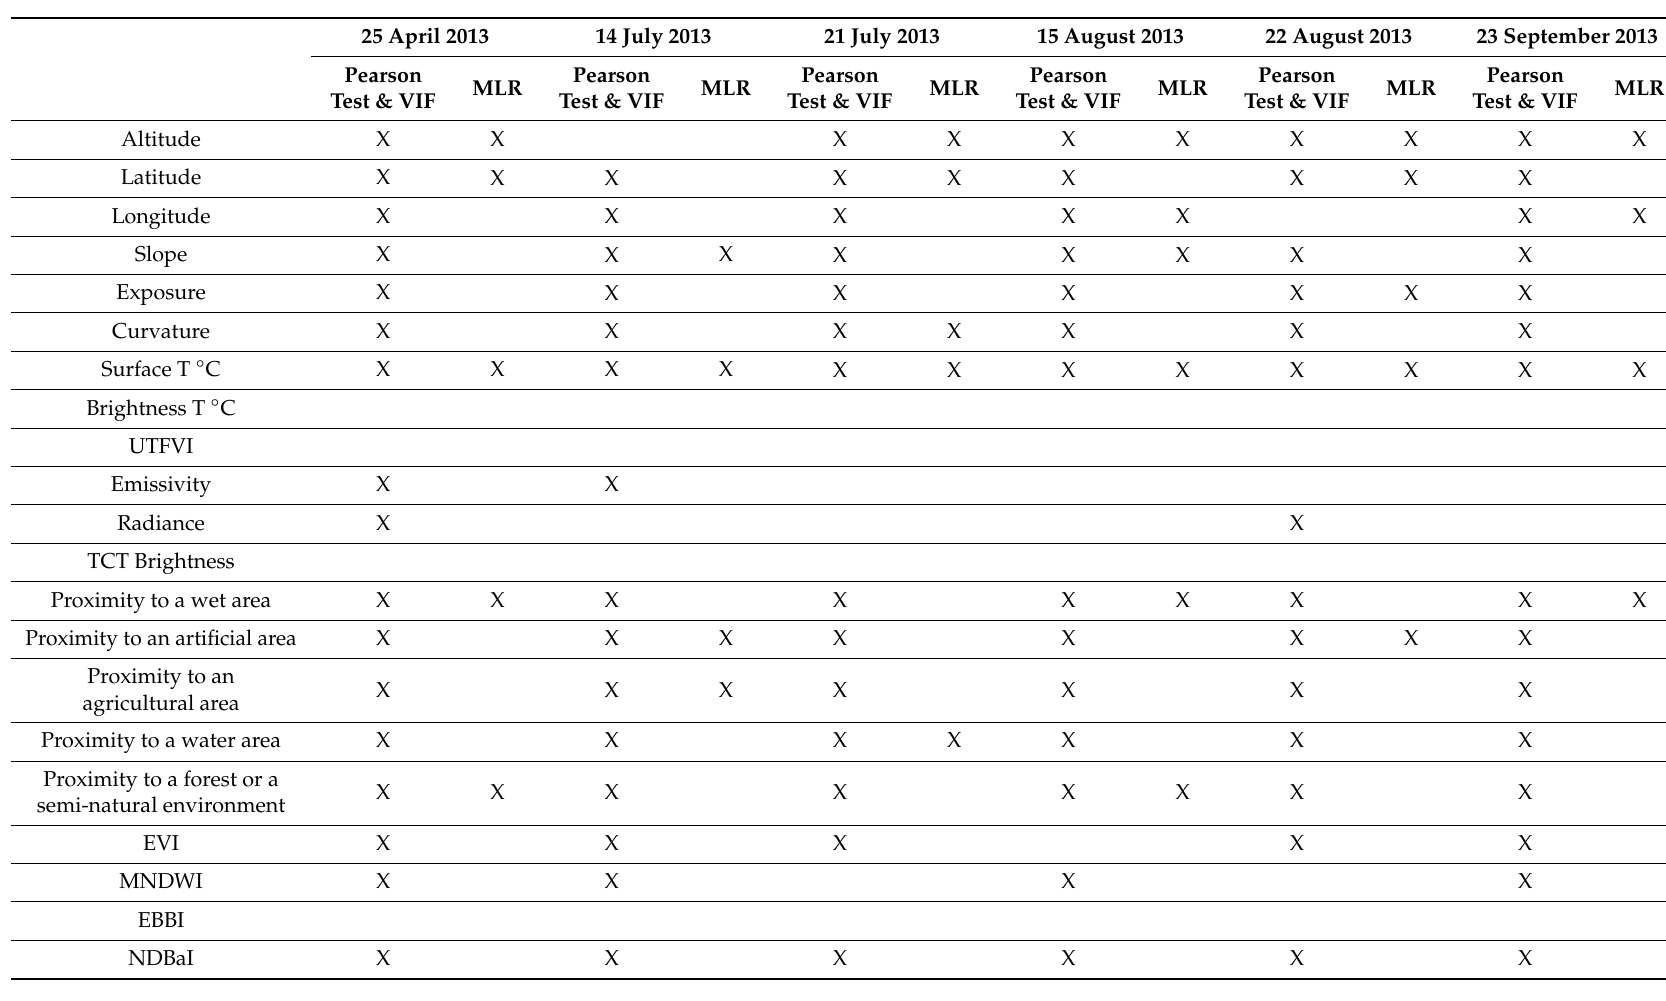
Table 4. Variables retained (shown by the crosses) after statistical tests (Pearson test and Variance Inflation Factor (VIF)) and multiple linear regression (MLR) for each day